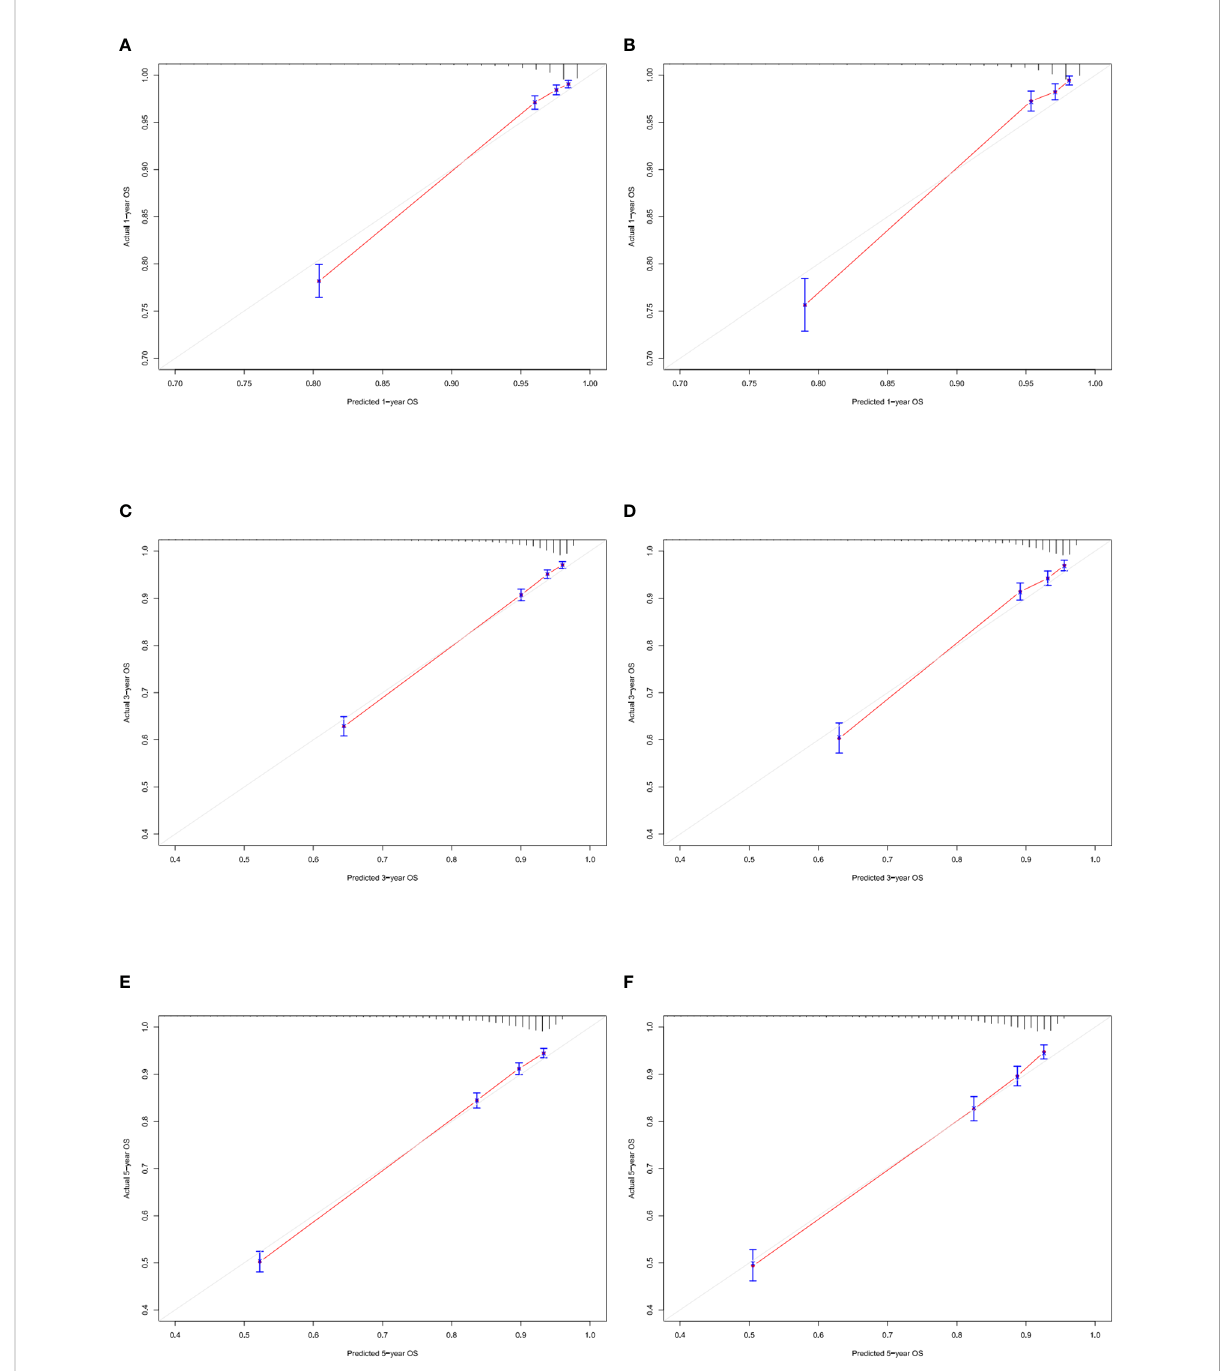
FIGURE 4 Calibration curves of nomogram. (A – C) For 1-, 3-, and 5-year OS in training cohort; (D – F) For 1-, 3-, and 5-year OS in validation